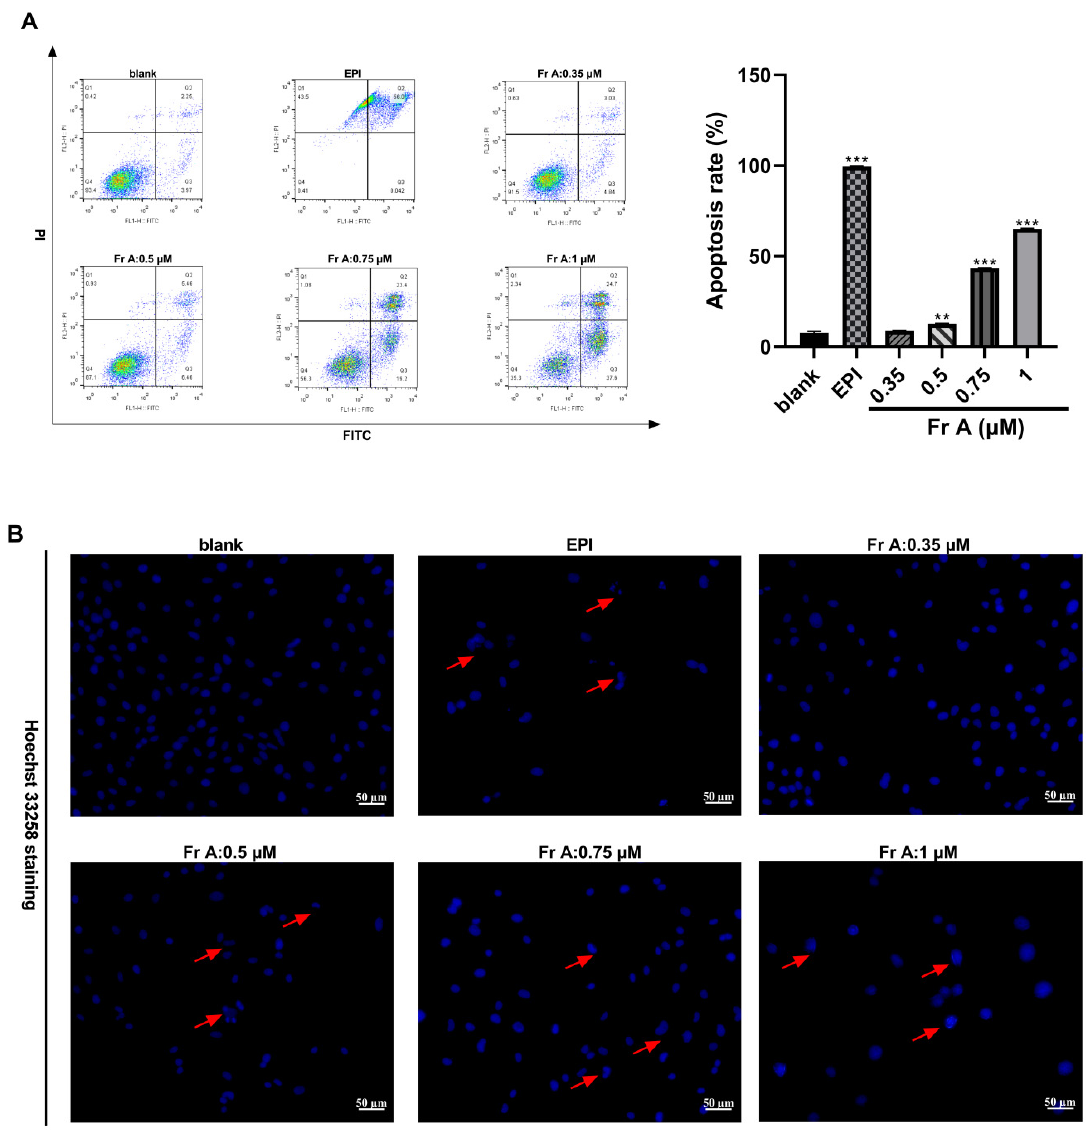
Figure 3. Effects of Frondoside A (Fr A) treatment on apoptosis and cell morphology in UM-UC-3 cells. Cells were treated with increasing concentrations of Frondoside A for 48 h, and EPI (10 µ M) as positive control. The induction of cell apoptosis ( A ) and the morphological changes (the pictures were taken at × 200 magnification) ( B ). Data are expressed as mean ± S.E.M. ** Significantly different at p < 0.01. *** Significantly different at p < 0.001.